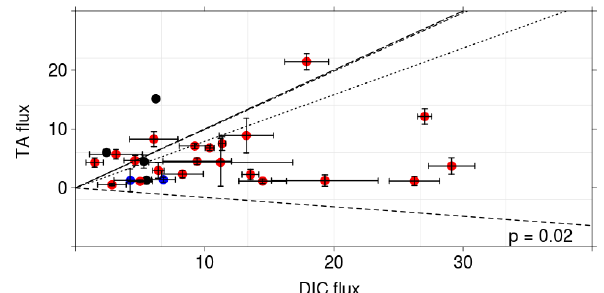
Figure 11. Correlation between A T and DIC fluxes for sites of the SNS from both campaigns. Different lines represent different re- action stoichiometry. For more explanation and reaction equations, see the text. Short dashed line: aerobic respiration; dotted line: den- itrification; dotted–dashed line: sulfate reduction coupled to pyrite formation and burial; long dashed line: carbonate dissolution. Note that the latter two lines are plotted along similar points and are thus hard to distinguish. p : Spearman’s rank correlation coefficient for the correlation of all points displayed in this scatter plot. All fluxes in mmolCm − 2 d − 1